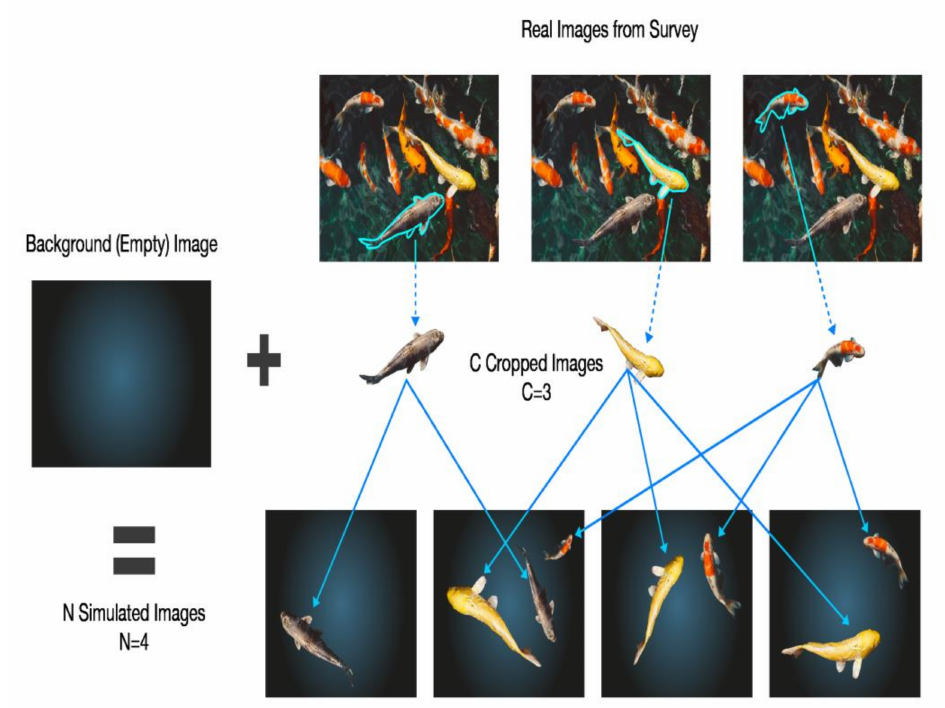
Figure 31. To generate images that realistically resemble Deep Vision